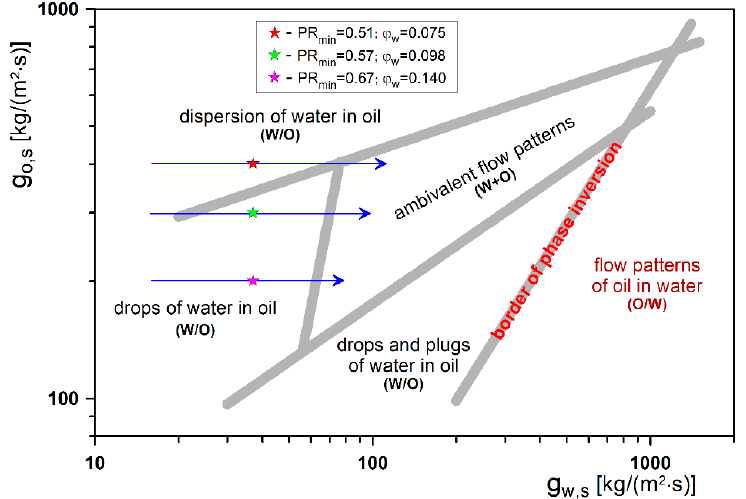
Figure 12. Selected series of simulations for η r =100 vs. two-phase liquid–liquid flow structures.